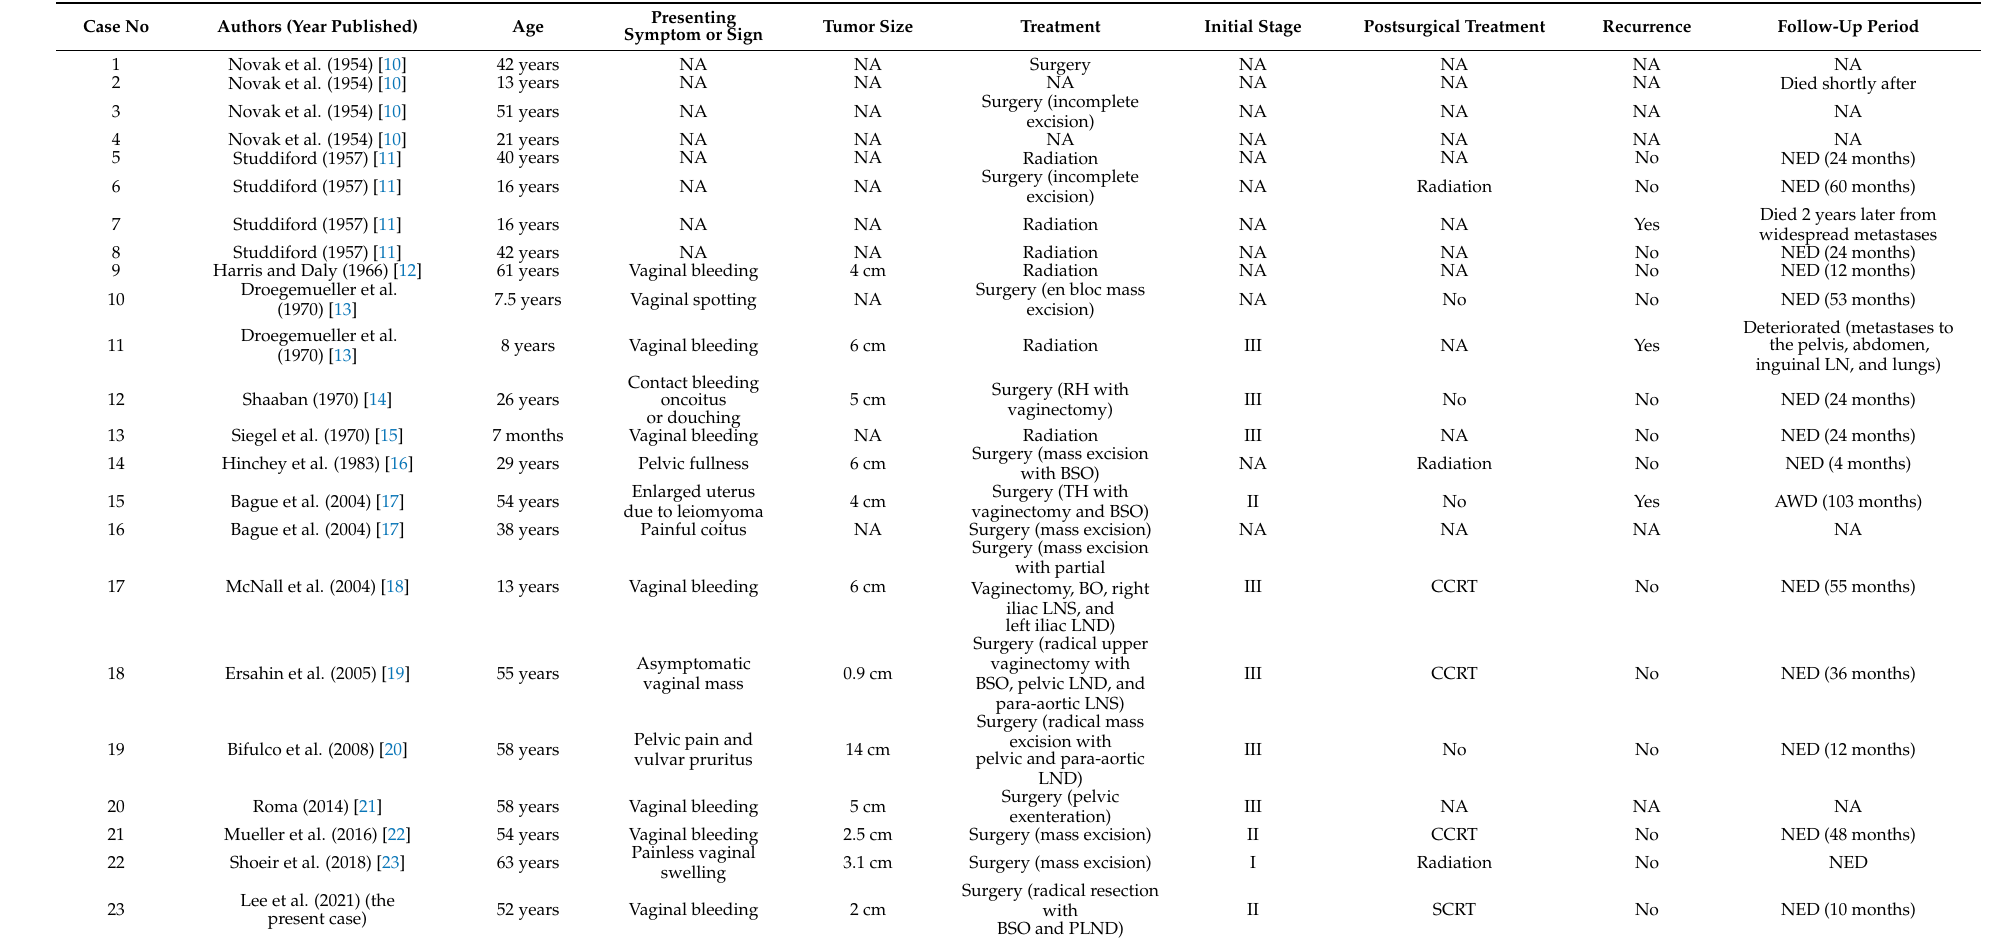
Table 2. Clinical characteristics of vaginal mesonephric